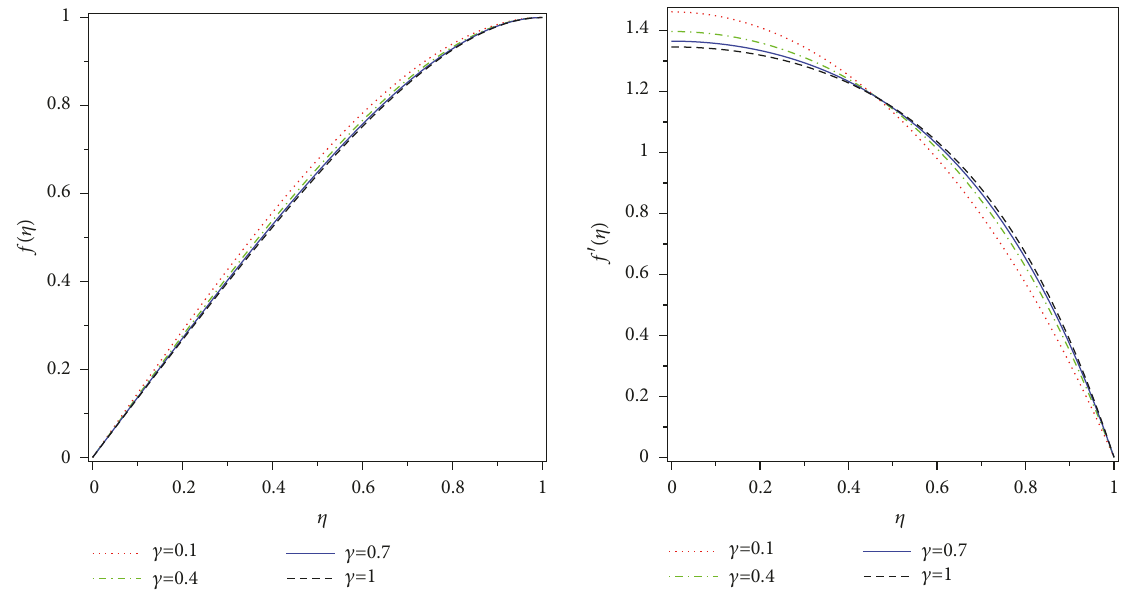
Figure 4: 𝑓(𝜂) and 𝑓 󸀠 (𝜂) for the values 𝛾 when 𝑀 = 2 , 𝑆 = 4 .